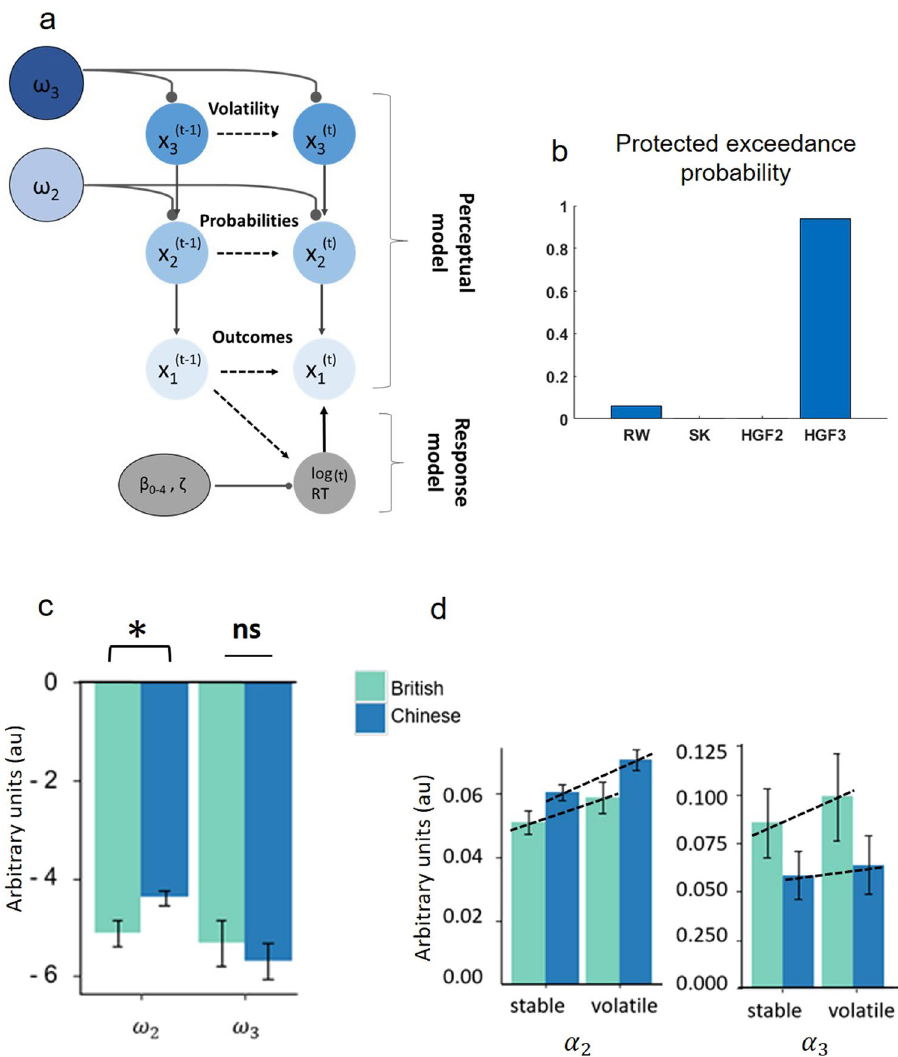
Figure 2. Computational model and model based results for PAL task. ( a ) Shows a schematic of the three level HGF model. See main text and methods for full model details. ( b ) Shows the results of the model comparison. ( c ) Chinese participants tend to have a higher ω 2 than British participants, but there are no cultural differences in ω 3 ( d ) While all participants increase their learning rates in response to volatility, there is no cultural difference in updating either α 2 or α 3 when switching from stable to volatile task phases. rw = Rescorla Wagner, sk = Sutton-K1, HGF 2 = two level HGF, HGF 3 = three level HGF. * denotes group differences with significance p < 0.05. Dotted lines show the linear increase in learning rate between stable and volatile task periods for each